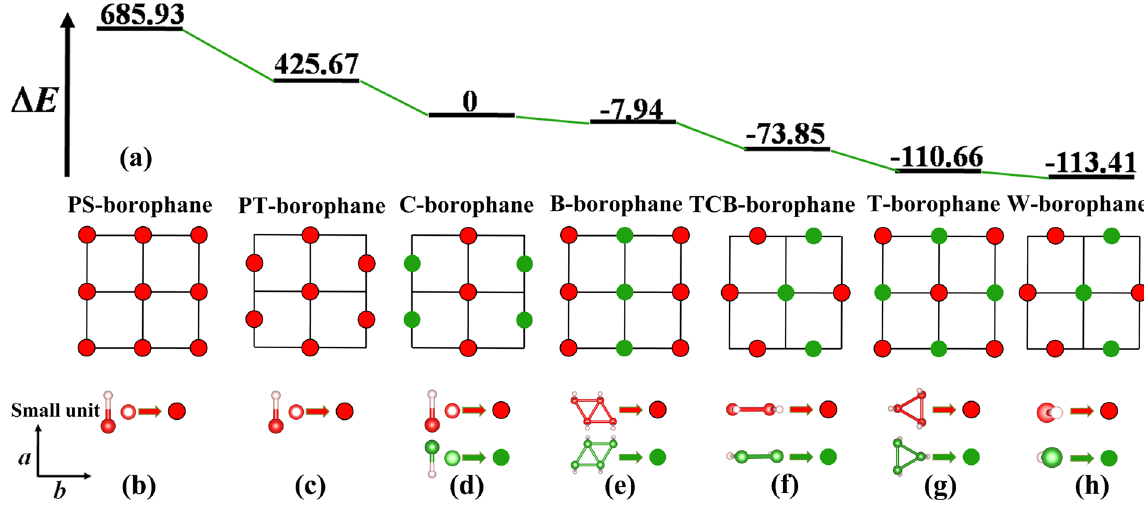
Figure 4. ( a ) The total-energy difference that referred to the total-energy C-borophane of different borophane conformers. Schematic drawings of the small units arrangements in ( b ) PS-, ( c ) PT-, ( d ) C-, ( e ) B-, ( f ) TCB-, ( g ) T- and ( h ) W-borophane.